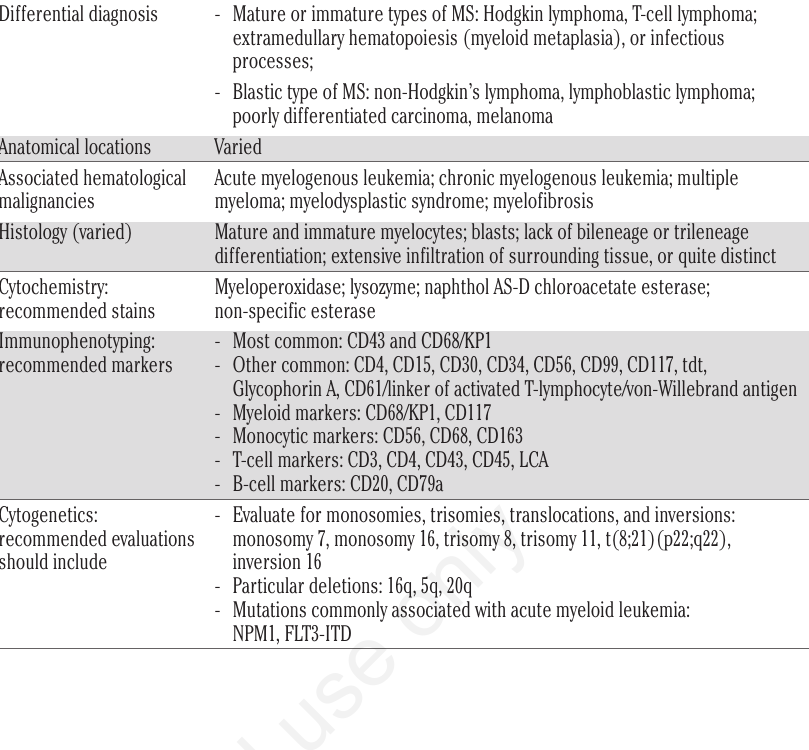
Table 1. Guidelines for diagnosing myeloid sarcoma